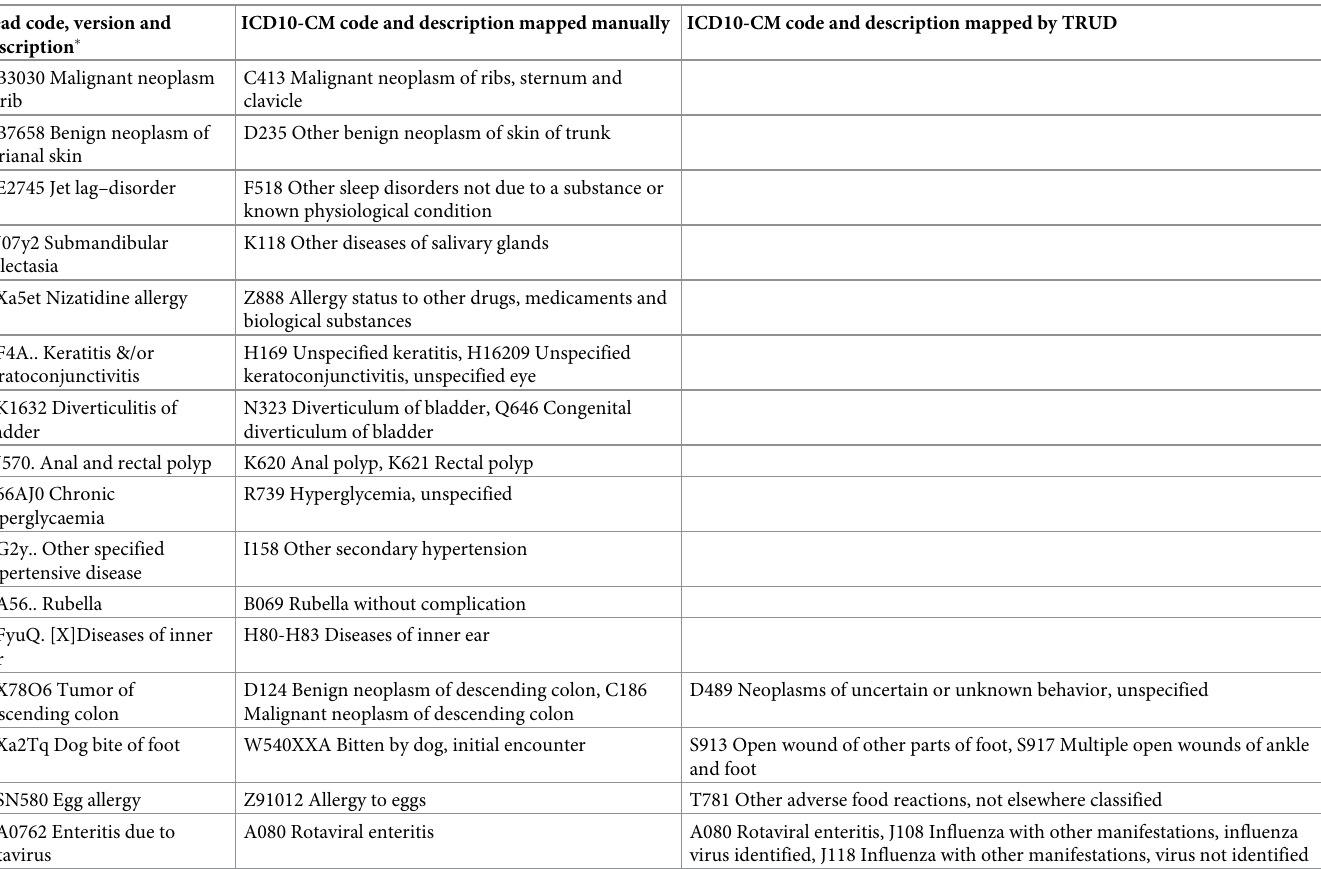
Table 2. Examples of mapping of Read codes to ICD10-CM codes. Mapping is performed manually or automatically using TRUD dictionary. Read code, version and description �